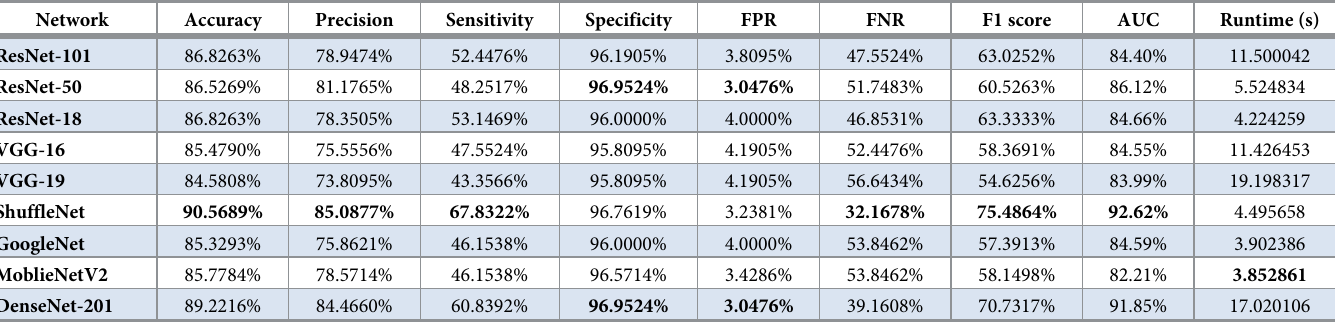
Table 2. Evaluation of the execution results of different network models for the classification of US images.